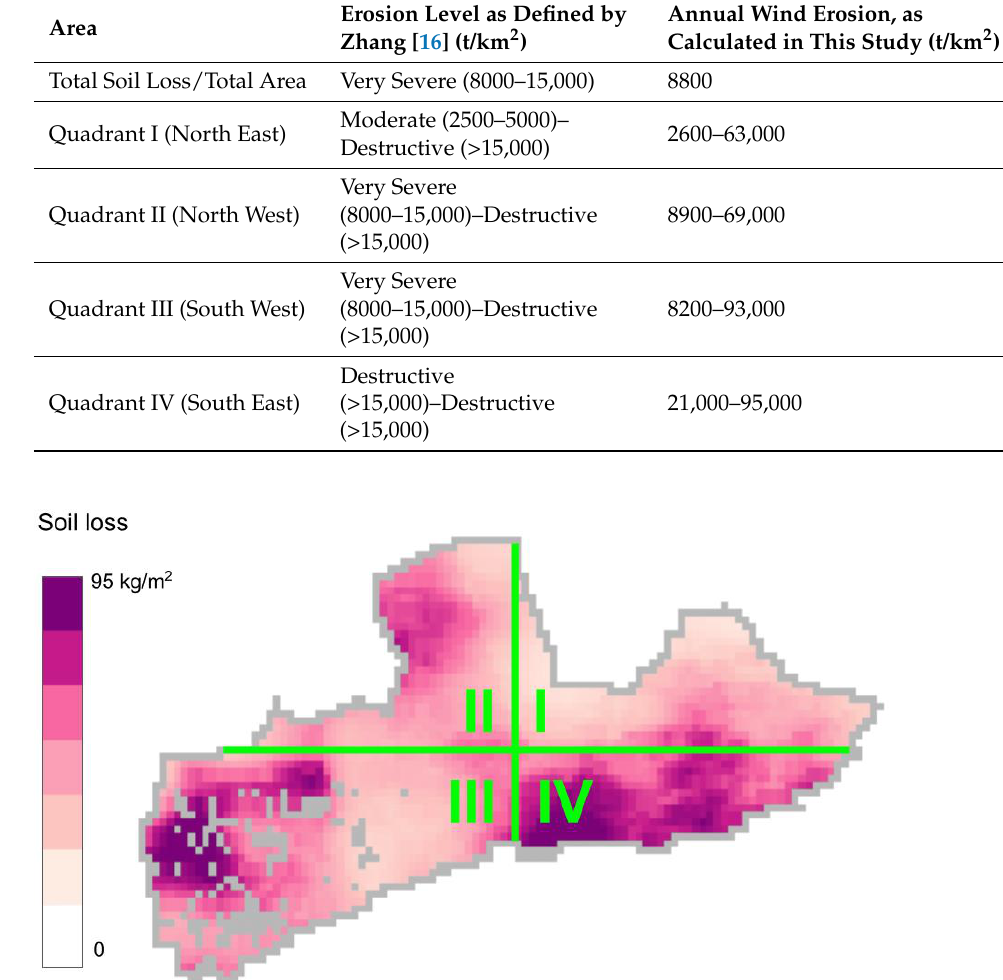
Table 3. Data comparison.